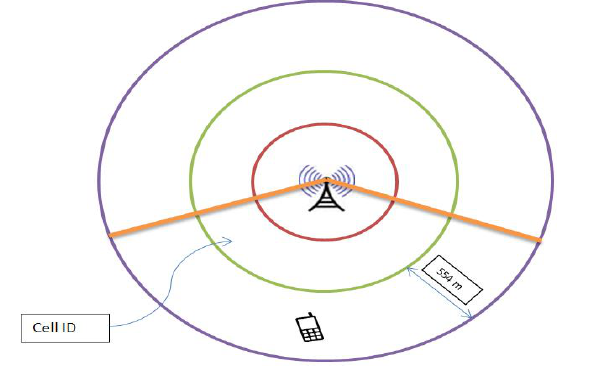
Figure 2. Cell ID & TA positioning method